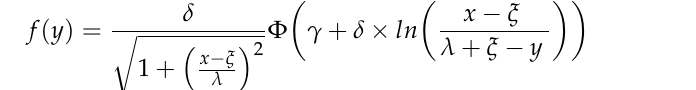
Table 4. Johnson Bounded Distribution fitting parameters.